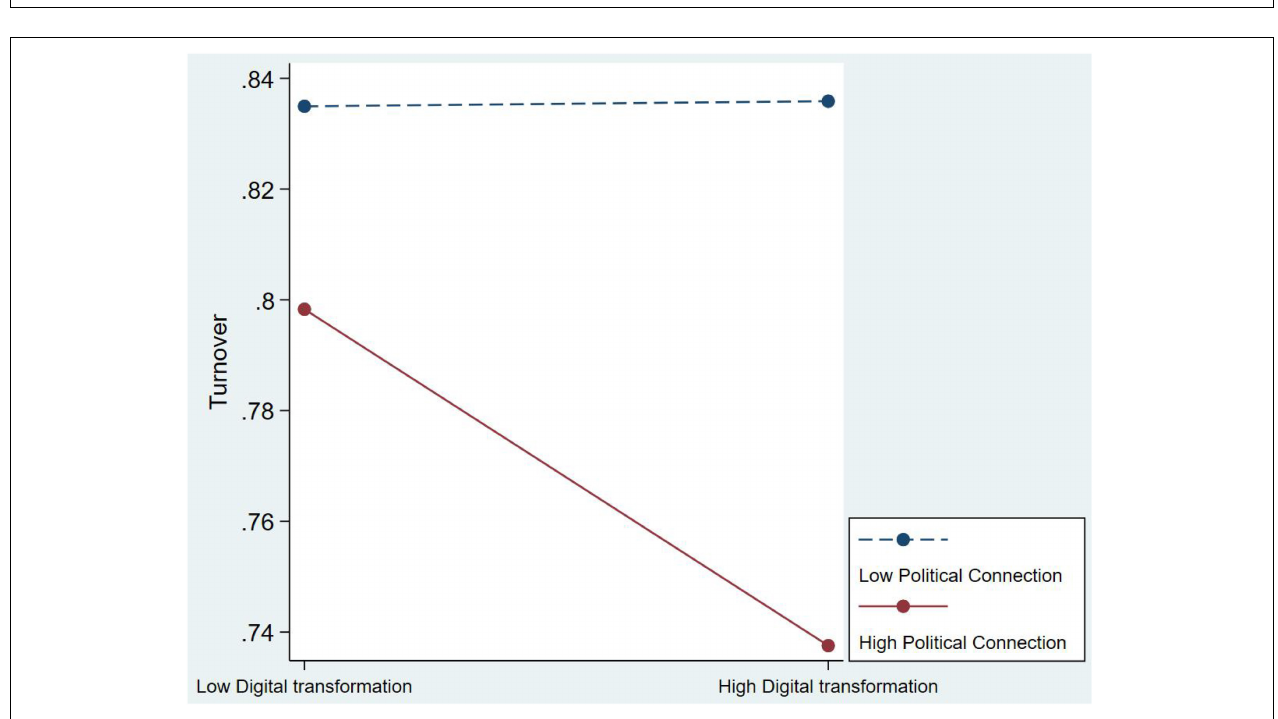
FIGURE 2 | The moderating effect of social network on digital transformation for Chairman and CEO’ turnover.